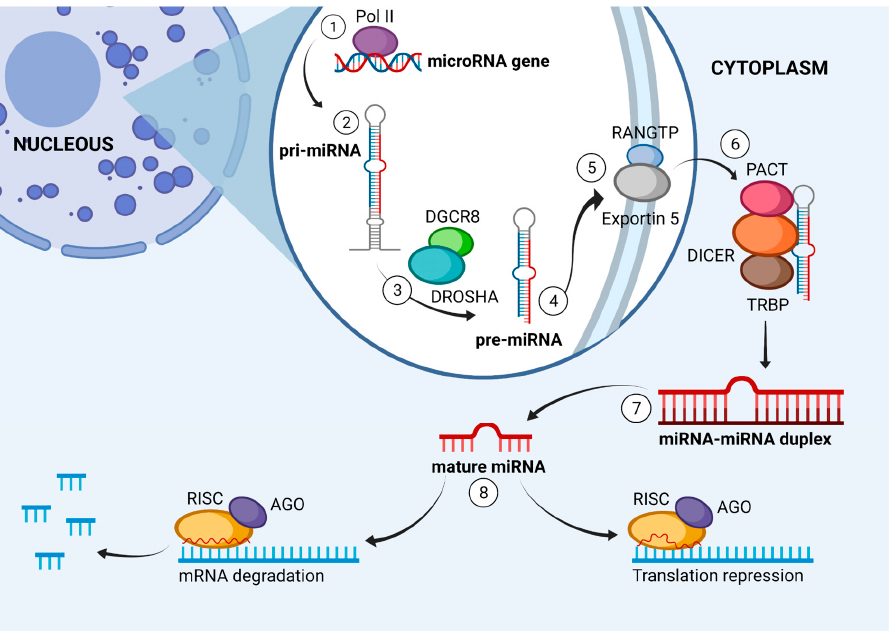
Figure 2. Graphical representation of the canonical miRNA biogenesis. 1. RNA polymerase II initiates long primary transcript (pri ‐ miRNA). 2. pri ‐ miRNA measures 500 to 3000 nucleotides in length and is shaped in the form of a loop. 3. DROSHA and DGCR8 form a microprocessor complex that forms miRNA precursor (pre ‐ miRNA) 4. pre ‐ miRNA is 70 to 80 nucleotides in length 5. Exportin ‐ 5 transports pre ‐ miRNA to cytoplasm. 6. DICER and other accessory proteins convert pre ‐ miRNA into mature miRNA 17 to 24 nucleotides in length. 8. AGO protein binds to strands of mature miRNAs and activates the RISC complex, causing repression or degradation of mRNA. Created with BioRender.com.